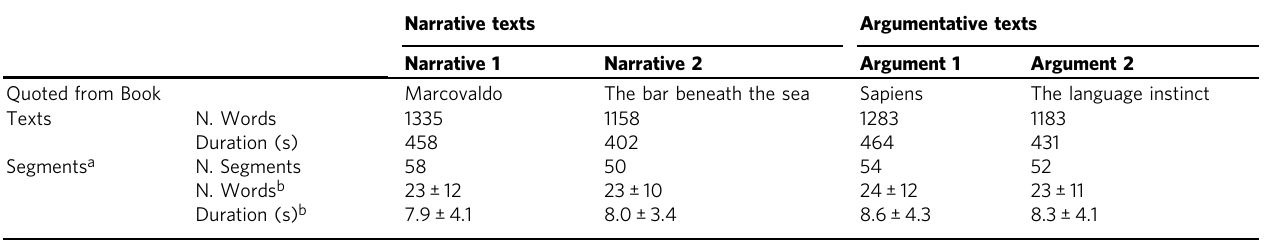
Table 1 Information on selected